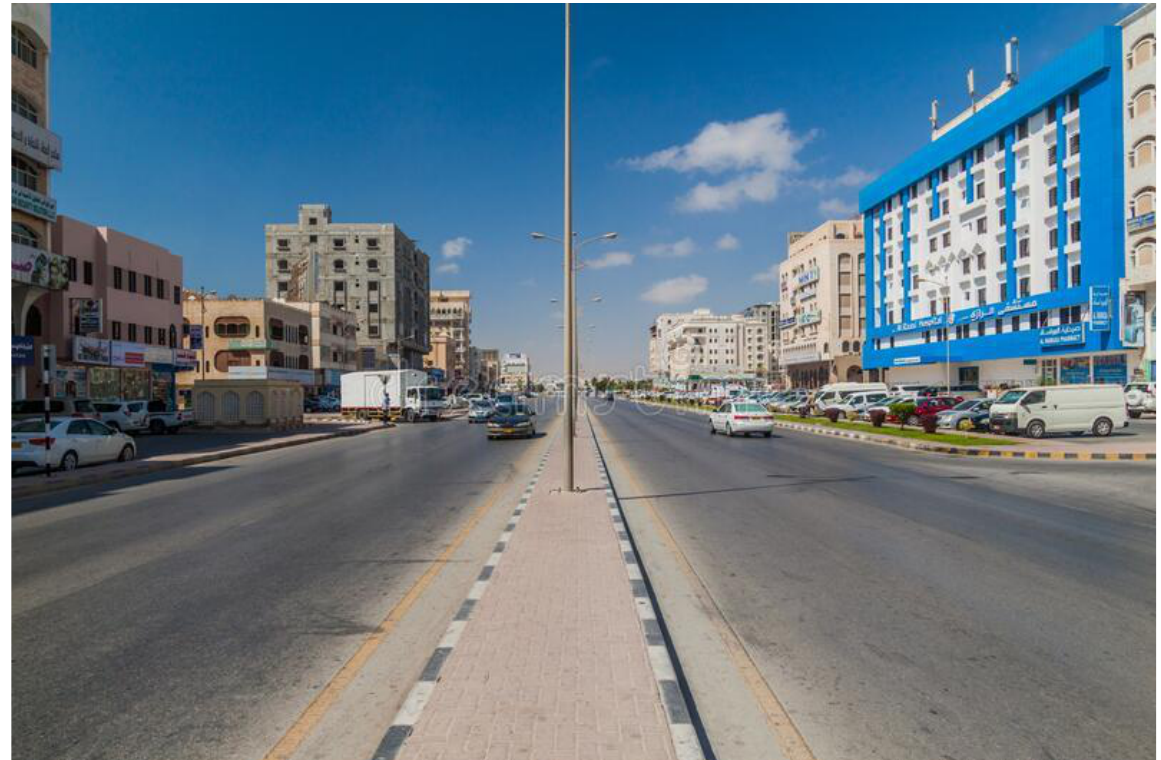
Figure 1. Urban Four-Lane Divided Roadways in Muscat